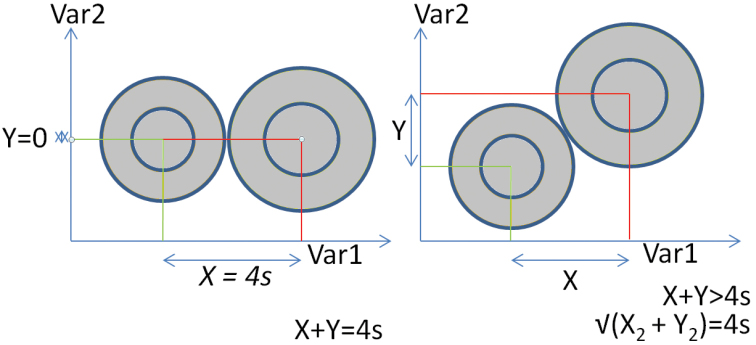
Justification for Euclidian summation, using a univariate/bivariate example.